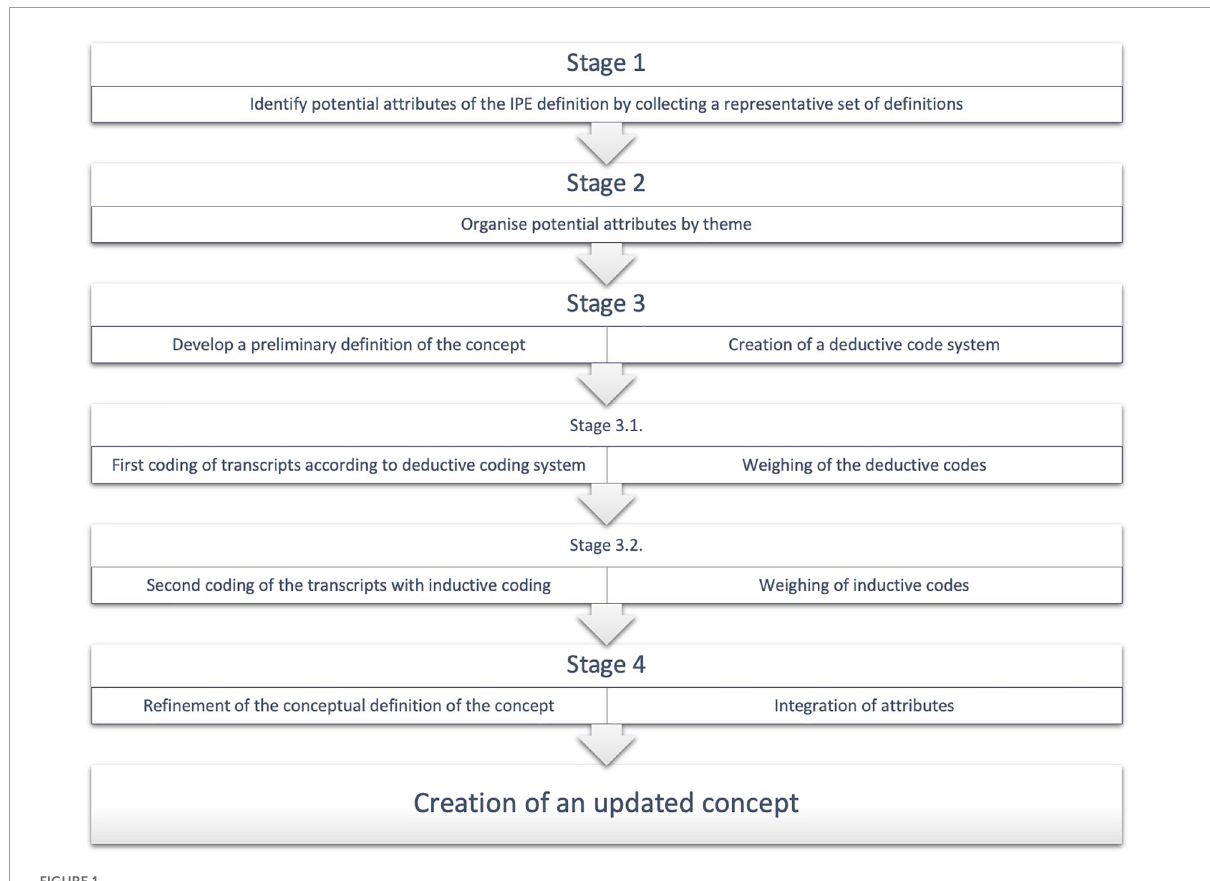
FIGURE1 Study flowchart. Stepwise approach to the creation of an updated concept. IPE, interprofessional education.